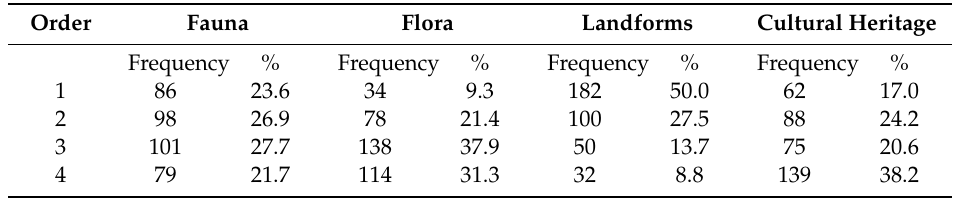
Table 2. Preferential ordering in responses to questions TI1 (Section TI, question 1) and TI2 (Section TI, question 2).